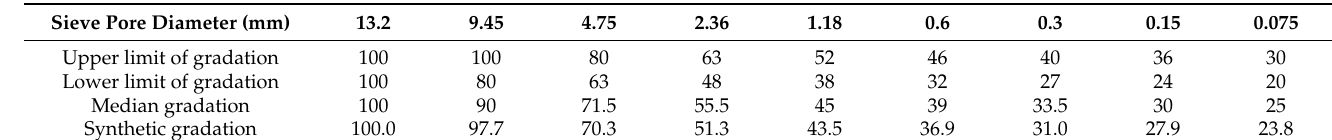
Table 10. Aggregate gradation of GA-10.